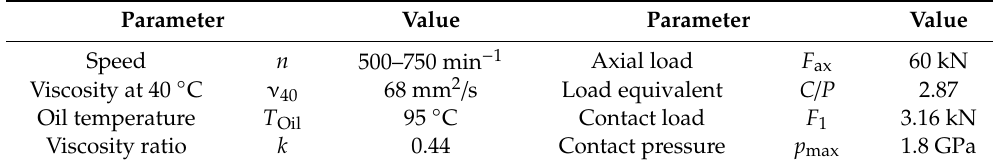
Table 4. Test conditions for fatigue testing of 81212 type tailored forming bearings.